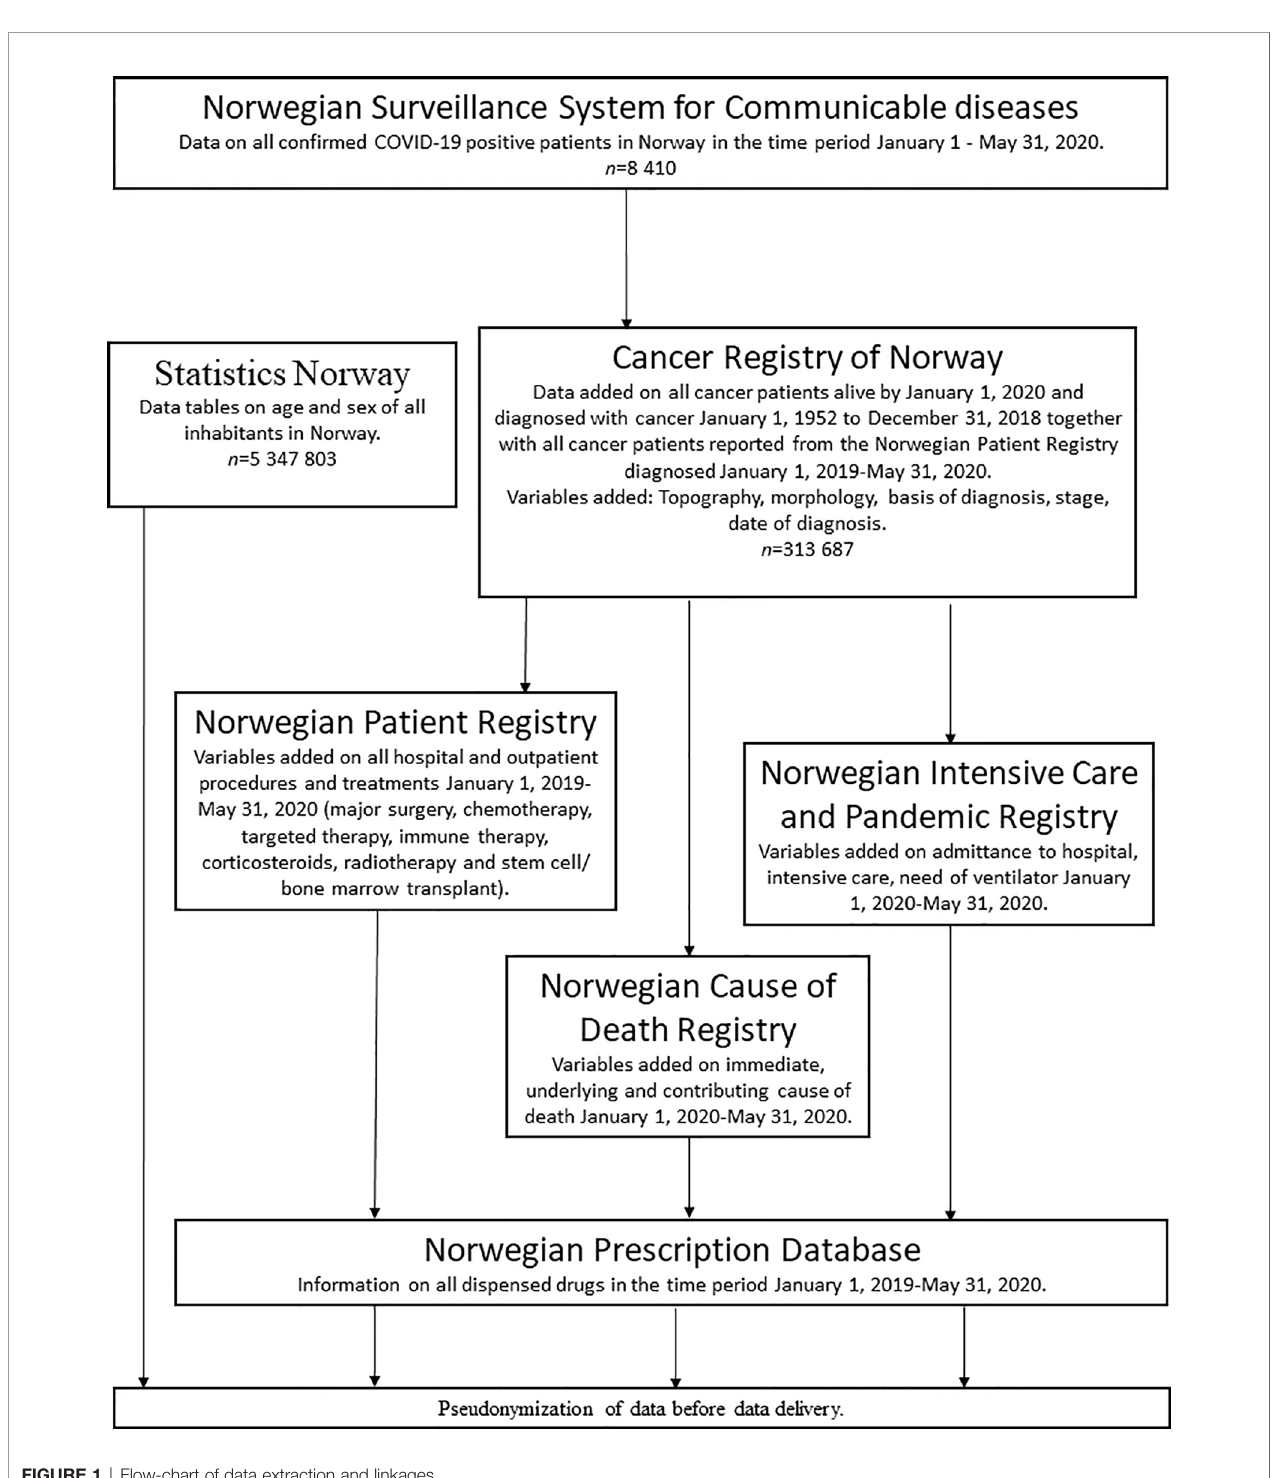
FIGURE 1 | Flow-chart of data extraction and